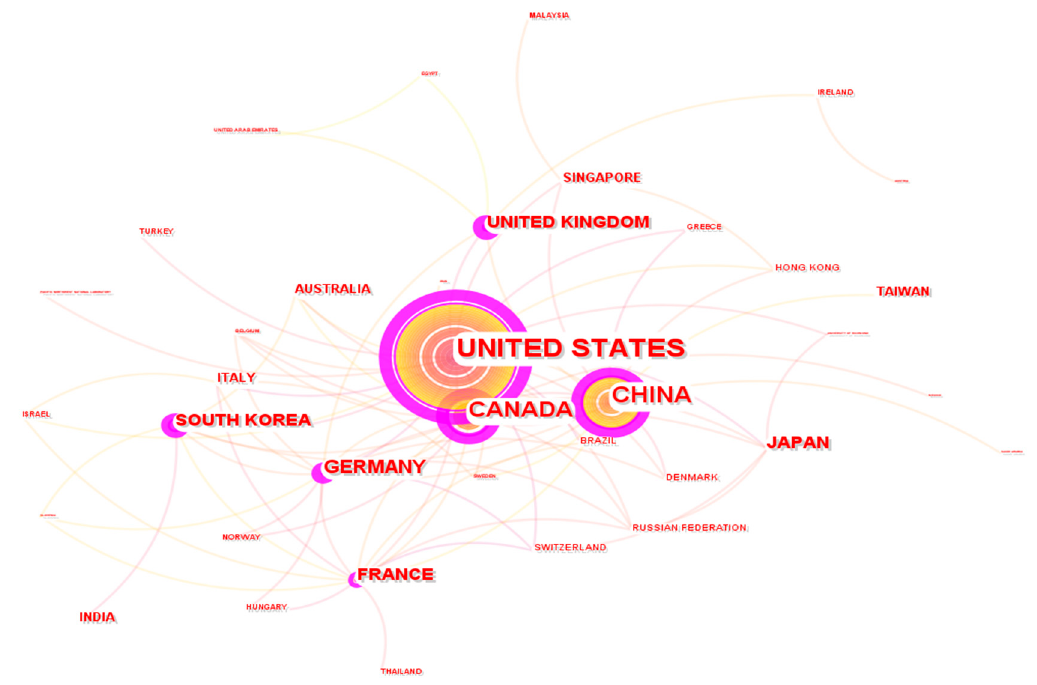
Figure 17. Top performing countries/regions and their collaboration characteristics based on 500 most cited PEMFC articles.